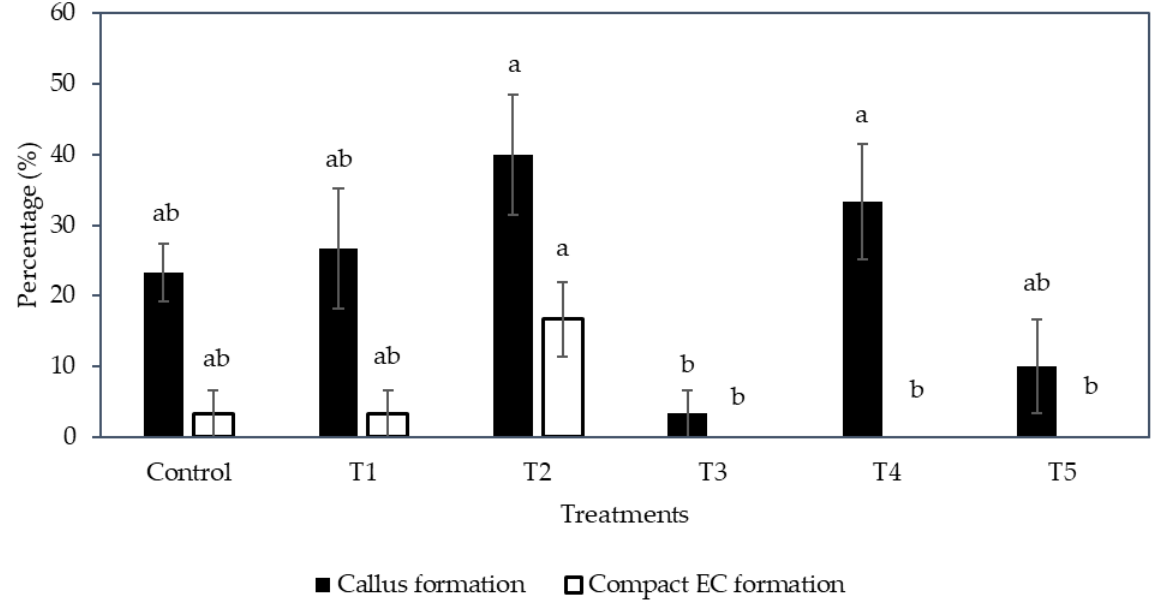
Figure 2. The effect of different medium types with various subculture frequencies (Control, T1 to T5, see Section 4.4) on the percentage of callus and compact embryogenic callus formed. The mean ± standard error for different treatments in each bar followed by different letters was significantly different for that parameter (Tukey’s test, p ≤ 0.05); n = 5.